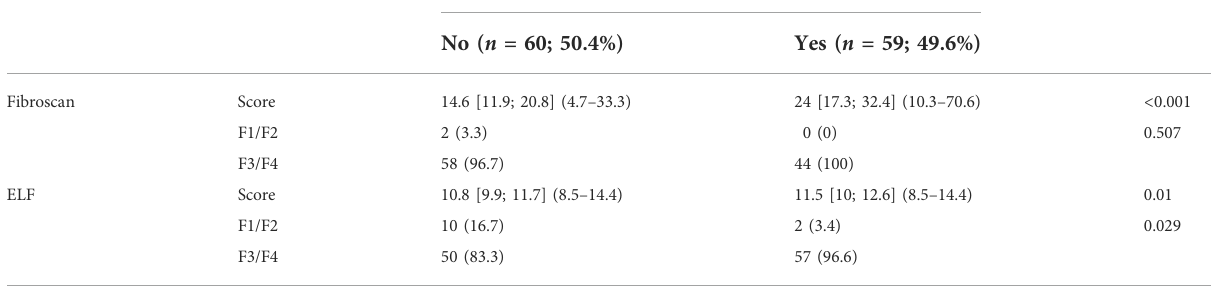
TABLE 3 ELF score and TE in patients with portal hypertension